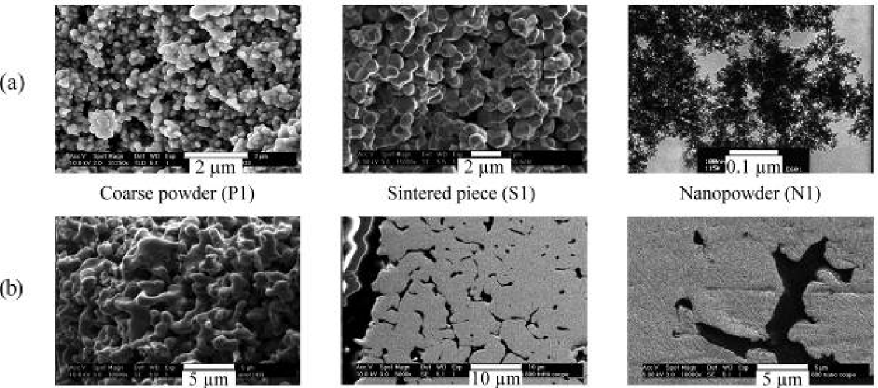
Figure 14. Cross-sections of the different samples ( a ) before and ( b ) after reduction [26].